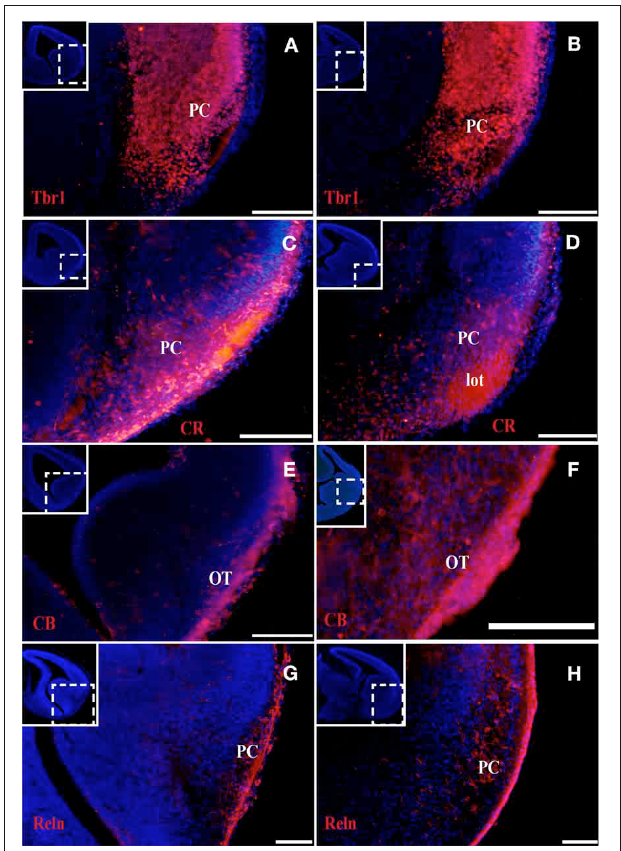
FIGURE 2 | Tbr1, CR, CB, and Reln (red) expression in the olfactory cortex at E14. (A–D) Tbr1 and CR expression in the rostral and the caudal regions of the piriform cortex. CR expression in the lot (D) . (E,F) CB is expressed in the OT but not the PC. (G,H) Reln expression is restricted to the outermost portion of the PC. Coronal sections; midline is to the left and dorsal is up. Blue corresponds to the bisbenzimide counterstaining. Scale bars: A–F , 500 µ m ; G and H , 100 µ